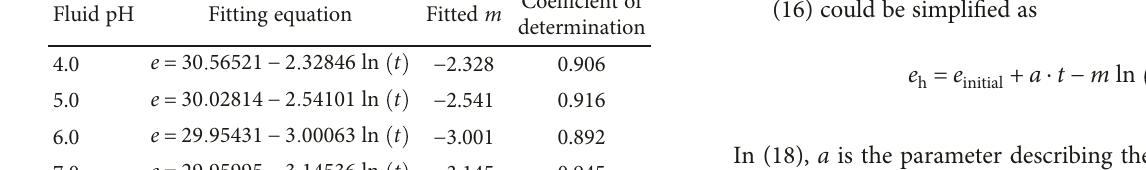
Table 4: Predicted Marcellus shale aperture evolution. Fluid pH Fitting